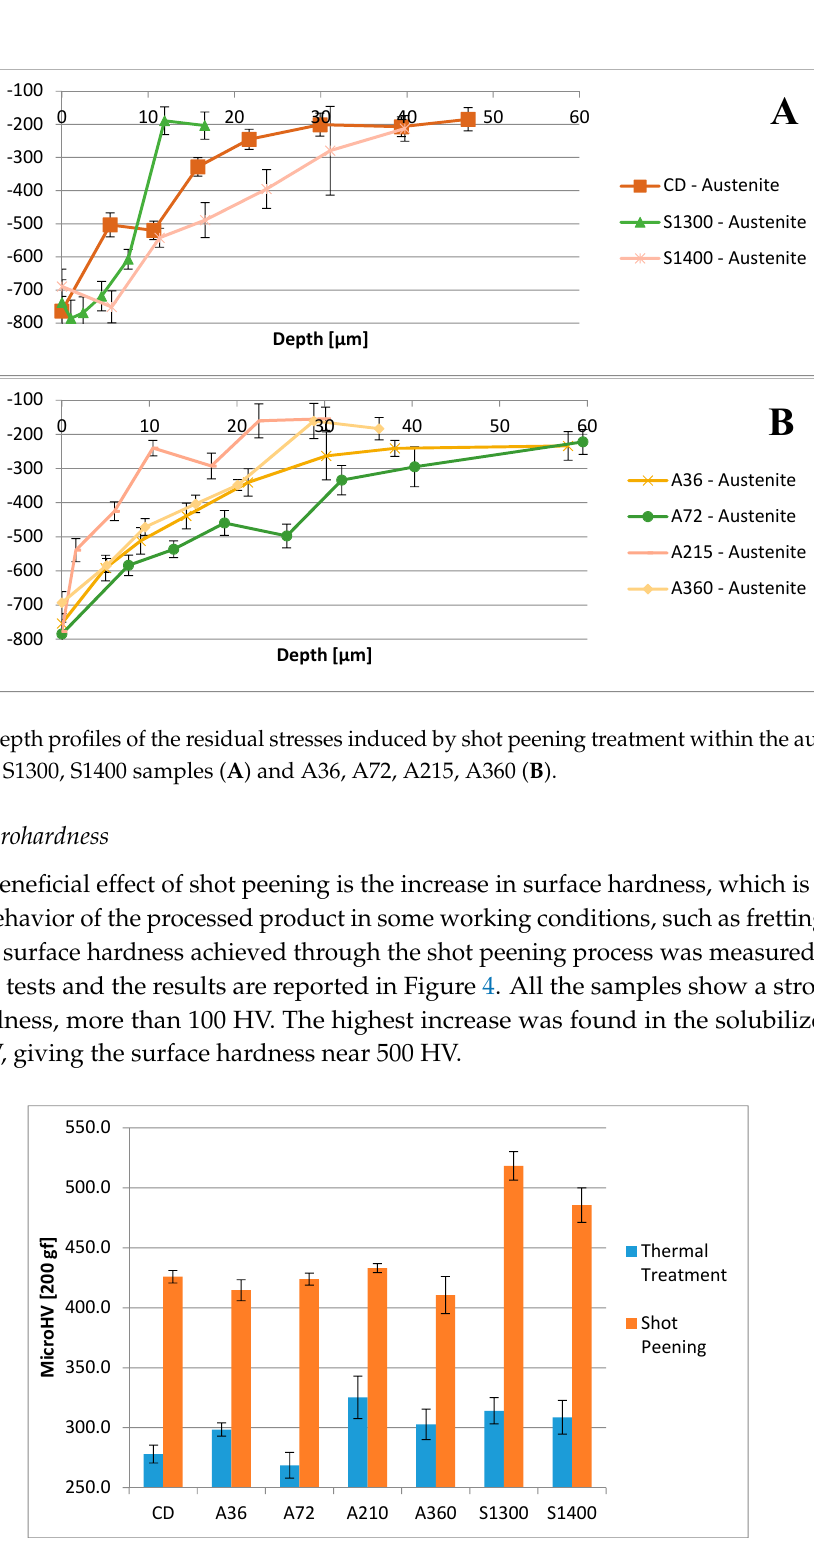
Figure 4. Surface hardness before and after shot peening treatment.